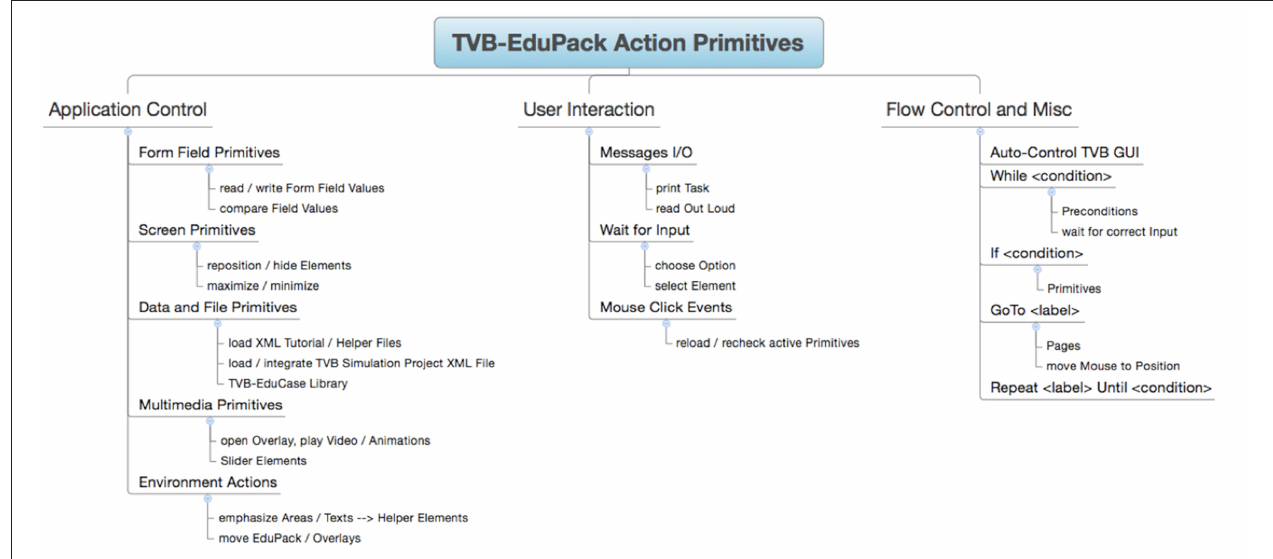
FIGURE 9 | Several applications of Action